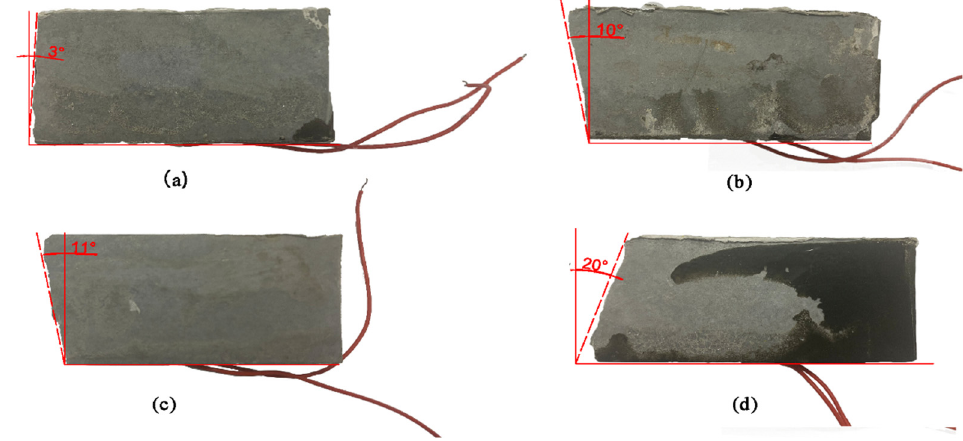
Figure 4. Typical fracture morphology of each group. ( a ) Control; ( b ) PF-PUC; ( c ) CF-PUC; ( d ) SF-